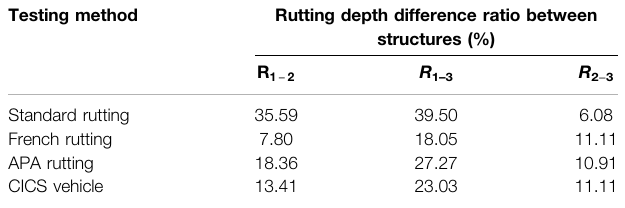
TABLE 6 | Rutting difference ratio between